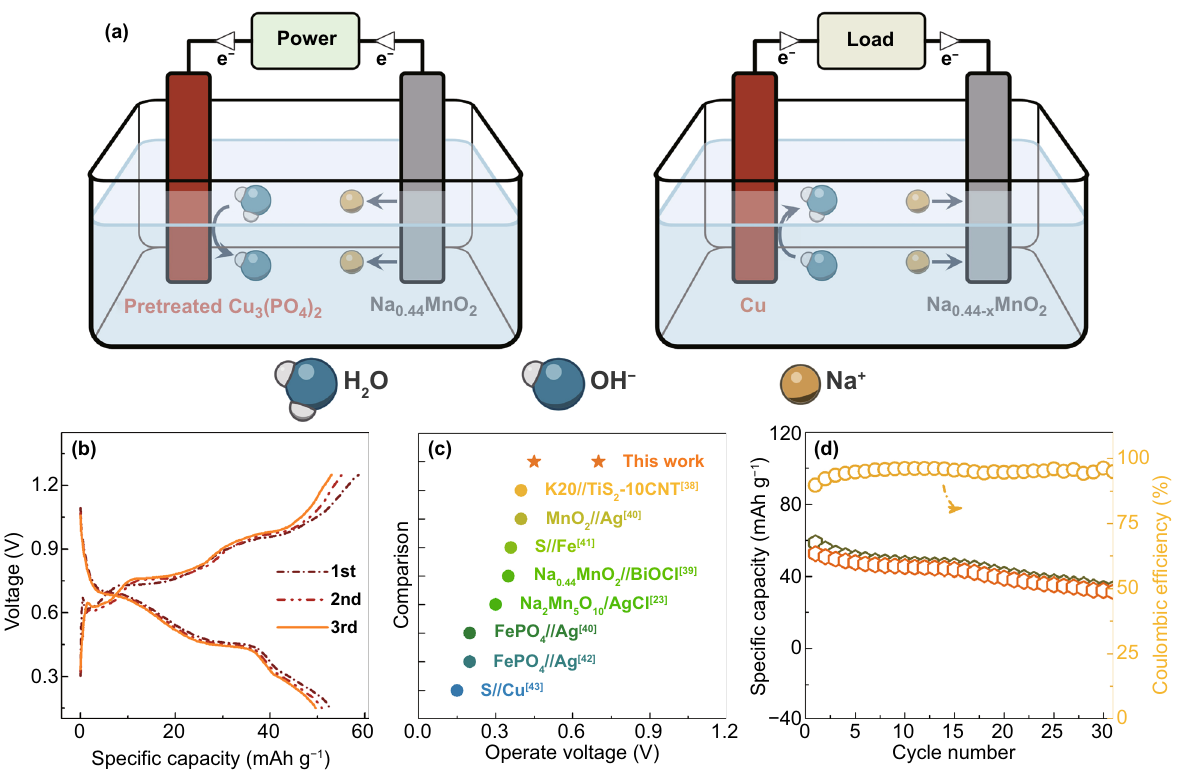
Fig. 3 a Schematic of pretreated Cu 3 (PO 4 ) 2 /Na 0.44 MnO 2 dual‑ion cell for charging and discharging (pretreated Cu 3 (PO 4 ) 2 electrodes is that the Cu 3 (PO 4 ) 2 electrodes is discharged and recharged in half cell for one cycle). b Galvanostatic discharge/charge profiles of pretreated Cu 3 (PO 4 ) 2 / Na 0.44 MnO 2 dual‑ion cell. c Operating voltage of pretreated Cu 3 (PO 4 ) 2 /Na 0.44 MnO 2 dual‑ion cell compared to the cells from previous studies. d Cycling performance of pretreated